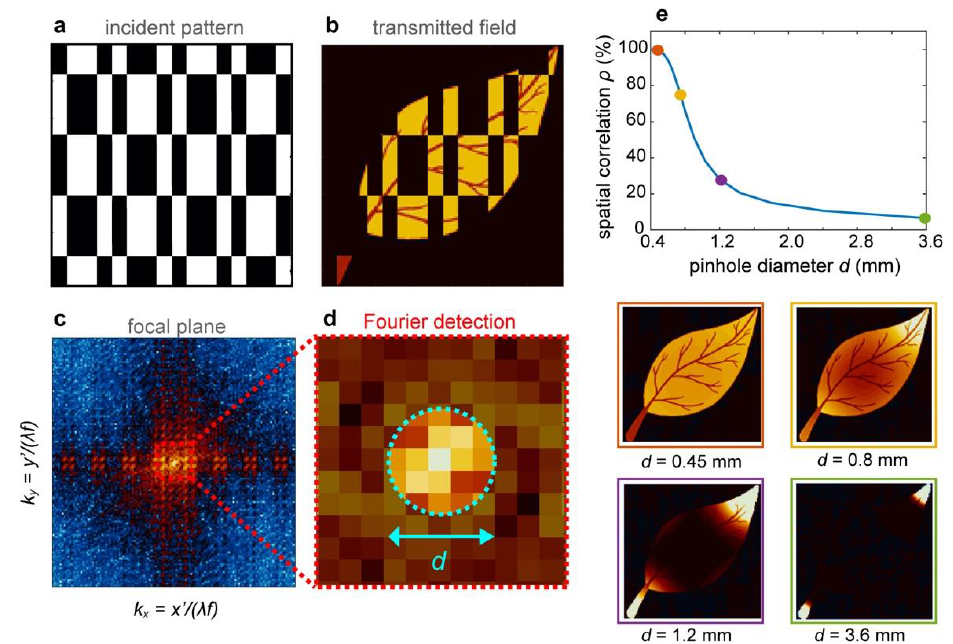
Figure 3. Influence of the pinhole size on the Fourier detection of TIMING reconstruction coefficients. (a – d) The spatial average of the transmitted field ( b ) associated with each incident pattern ( a ) could be measured by performing a point-like detection in the centre of the Fourier plane ( c , d ). In realistic implementations, the centre of the Fourier plane is sampled using a sampling function PH of finite diameter 𝑑 . ( e ) Spatial correlation between the reconstructed and original image as a function of the sampling function diameter. A departure from the point-like approximation led to a significant corruption of the reconstructed image (insets). Interestingly, the typical image degradation did not necessarily involve the total disappearance of highly resolved details.